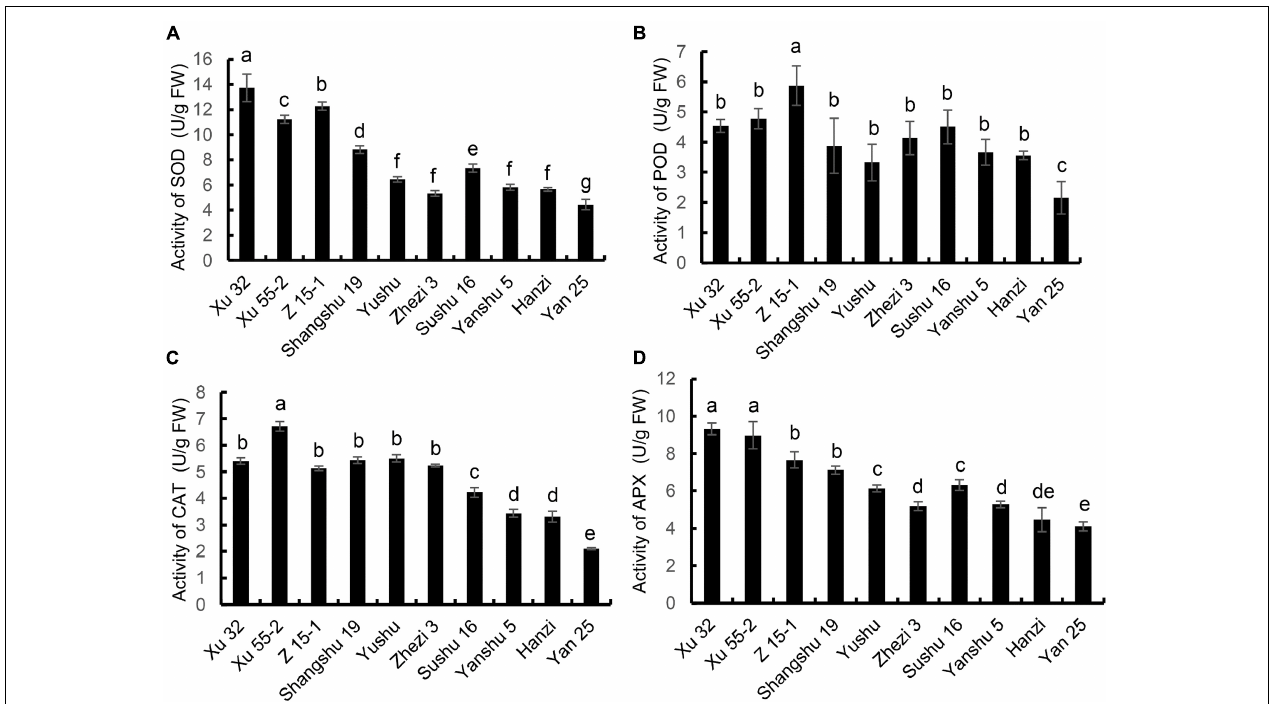
FIGURE 2 | The activities of (A) superoxide dismutase (SOD), (B) peroxidase (POD), (C) catalase (CAT), and (D) ascorbate peroxidase (APX) in the leaves of 10 sweet potato cultivars (i.e., Xu 32, Xu 55-2, Z 15-1, Shangshu 19, Sushu 16, Yanshu 5, Hanzi, Yushu, Zhezi 3, and Yan 25). Data are presented as means ± SD ( n = 3). FW, fresh weight.